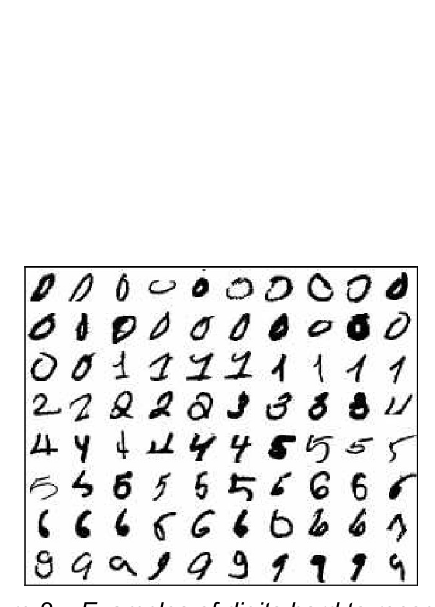
Figure 2 – Examples of digits hard to recognize Рис. 2 − Примеры труднораспознаваемых